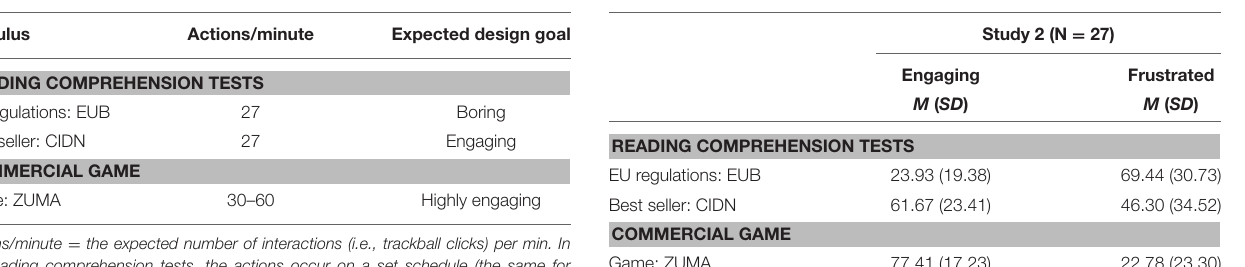
TABLE 7 | Summary of interactive stimuli used in this experiment. TABLE 8 | Subjective ratings elicited by each interactive stimulus.